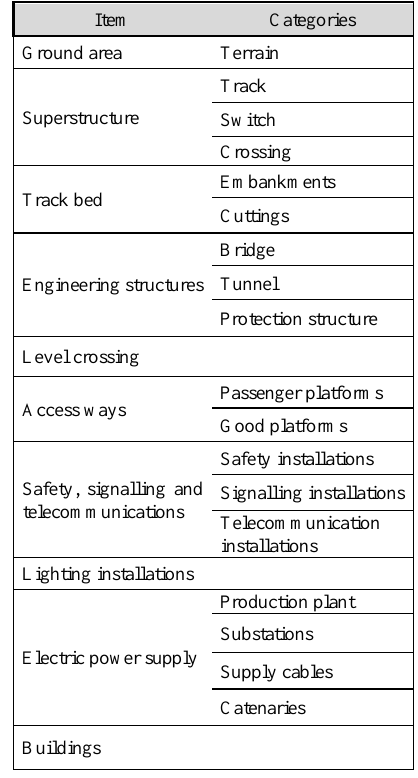
Table 1. Items and categories of the railway infrastructure (European Parliament, 2012).